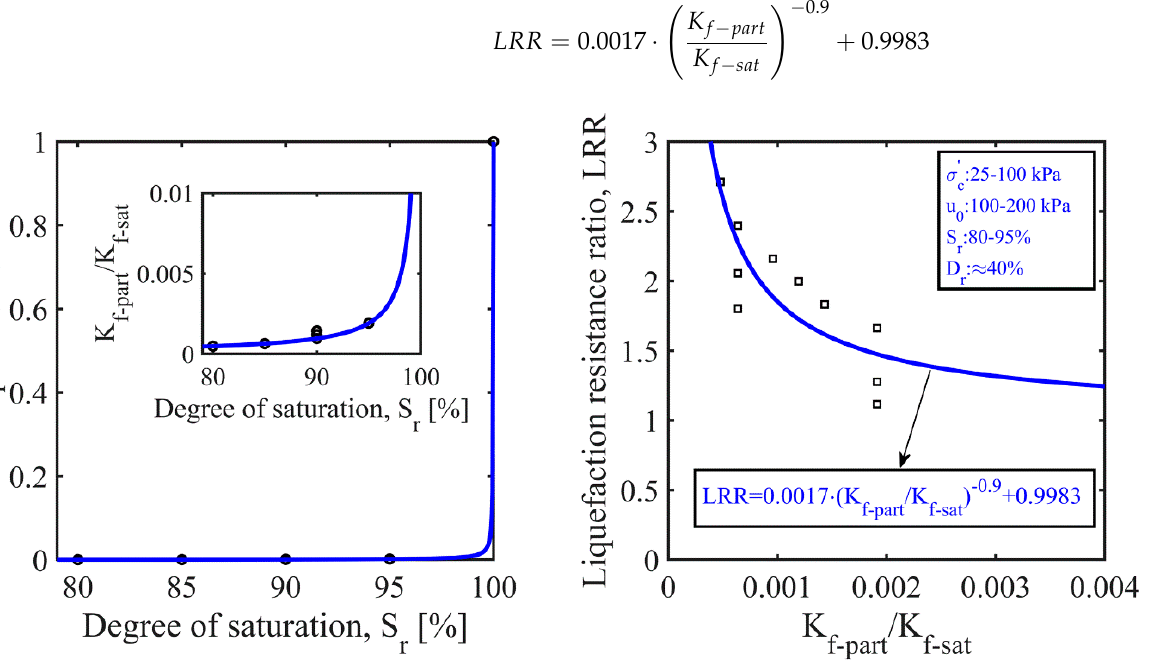
Figure 13. Variation in liquefaction-resistance ratio with normalized bulk modulus of pore